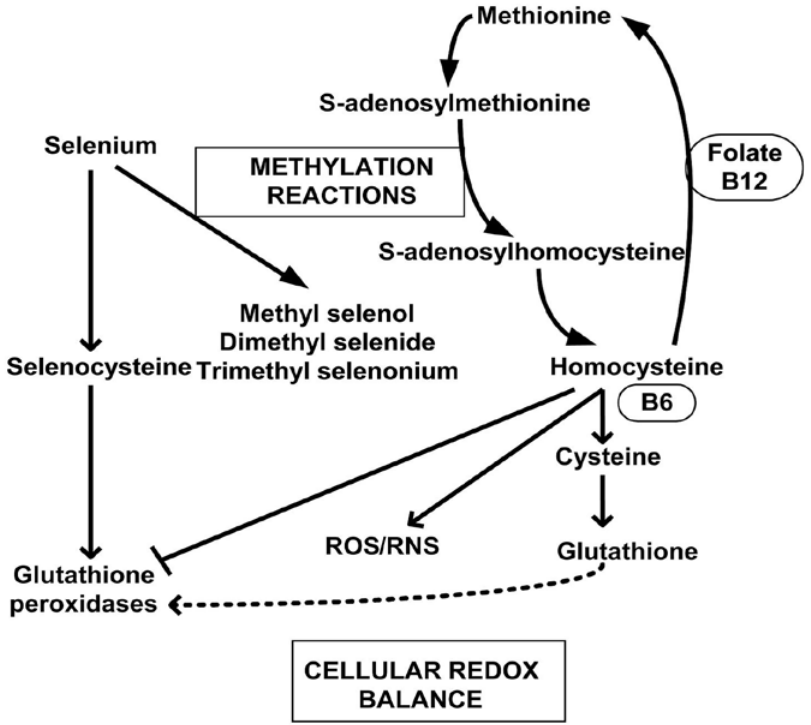
Figure 6. Important selenium methylation reactions and redox species in the maintenance of cell’s redox balance, adapted from